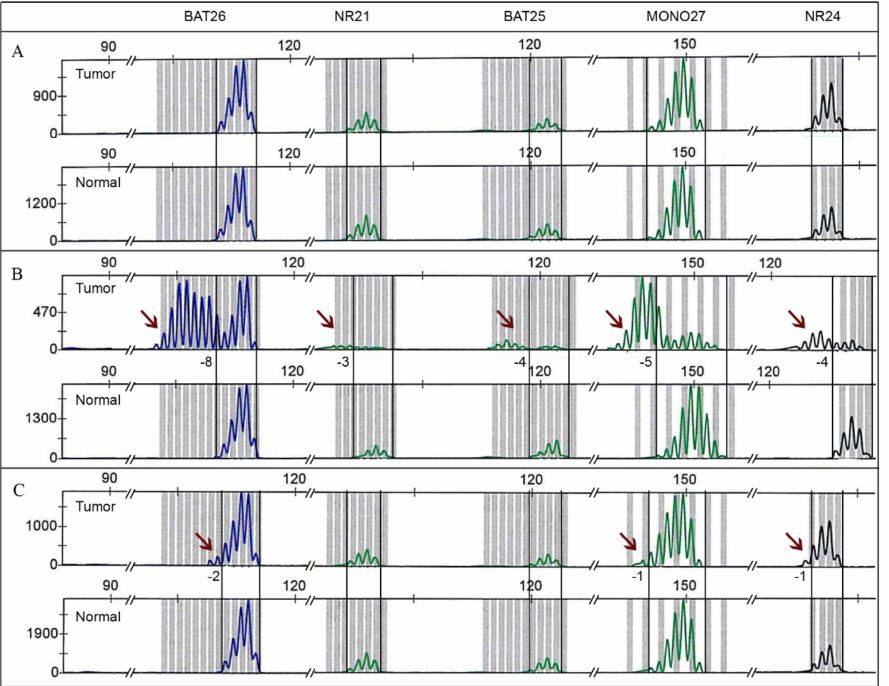
Figure 2. Different microsatellite instability (MSI) profiles of endometrial cancer (EC) after PCR and fragment length analysis using the Promega panel. All pictured tumor samples are compared directly with its paired normal tissue. ( A ) Sample 22 (cohort one) representing a microsatellite stable (MSS) profile. ( B ) Sample 4 (cohort one) showing a microsatellite instability-high (MSI-H) case with shifts in microsatellite repeat length comparable to colorectal cancer (CRC) samples. Available counted peaks are labeled at the bottom of each tumor sample. Arrows highlight each shift event in microsatellite repeat length. ( C ) Deviant MSI profile of sample 10 (cohort one) with small additional peaks of − 1 to − 2